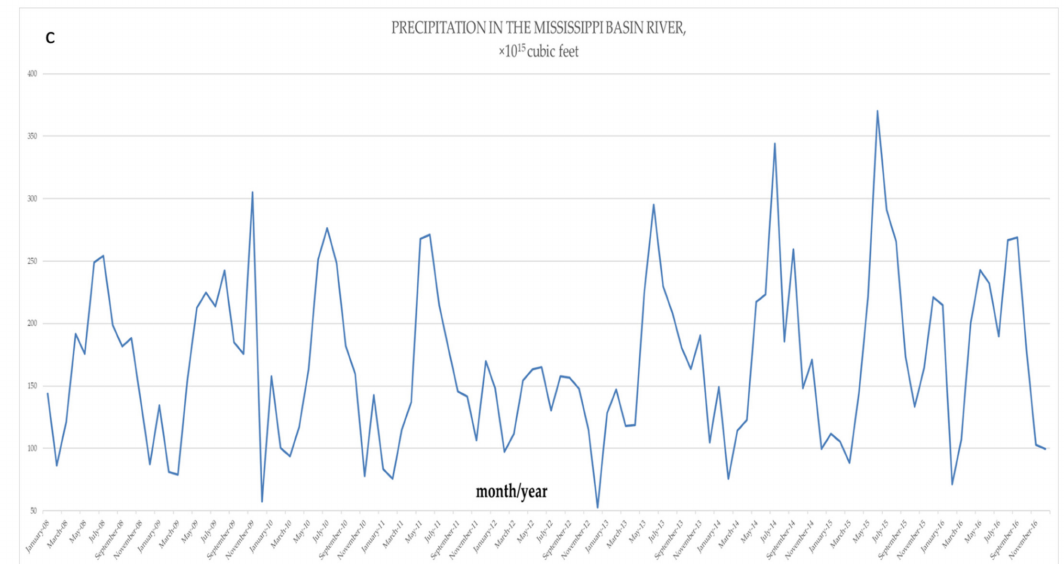
Figure 12. The Mississippi River, near New Orleans, Louisiana. ( a ) Monthly statistics graph based on water flow rate data in the Mississippi River. Water discharge behavior in the Mississippi River during the period from 1 January 2008 to 31 December 2016. ( b ) Monthly statistics graph based on the water table data of the Mississippi River. The groundwater level behavior in the Mississippi River from 1 January 2008 to 31 December 2016 (positive correlations). ( c ) Monthly statistics graph based on Mississippi basin rainfall data. Precipitation amount behavior in the Mississippi basin from 1 January 2008 to 31 December 2016. We received positive pair correlations for ( a , c ) and negative correlations for ( a , b ); the facts probably demonstrate a tendency to flooding. On the horizontal axis–the breakdown of data by year/month. On vertical axes–( a ) water discharge (in feet/sec); ( b ) groundwater level (in feet); ( c ) precipitation level (in cubic feet).